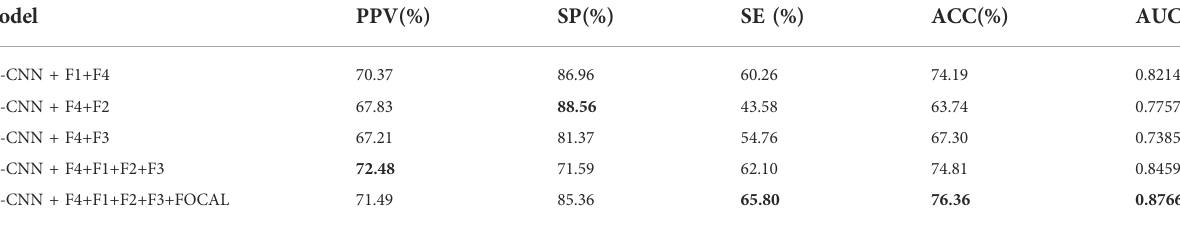
TABLE 6 Performance of fusing the deep and shallow features model on fi ve-fold cross-validation. Model